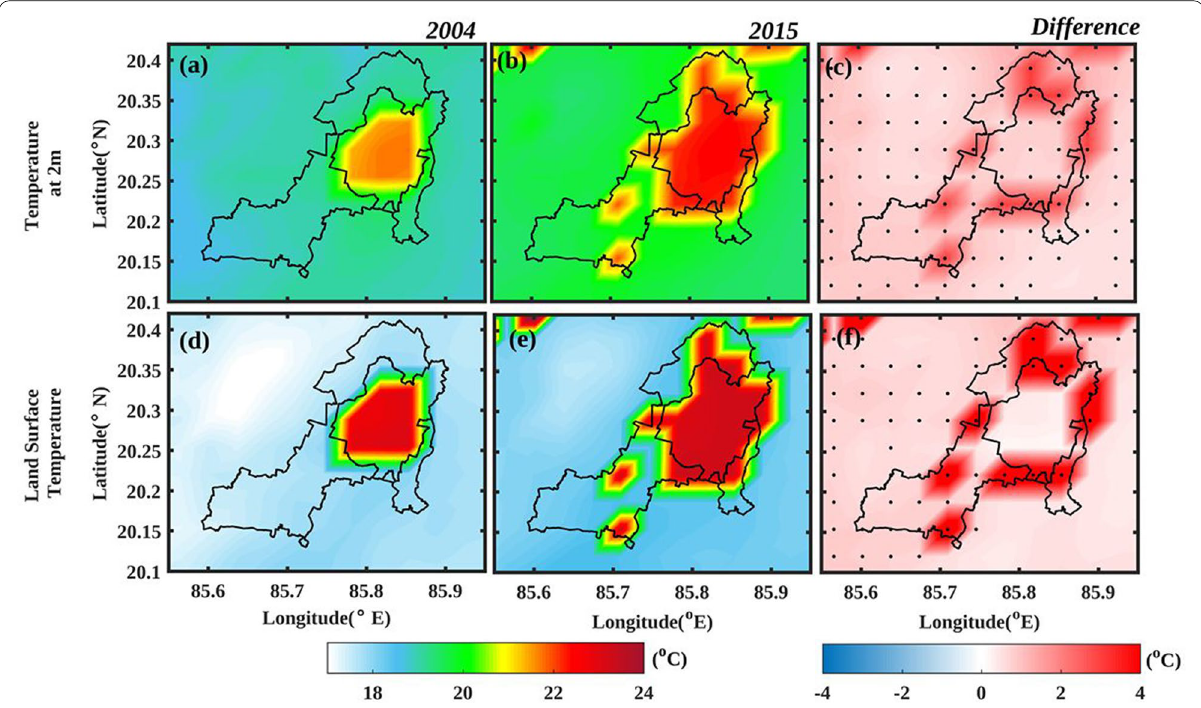
Fig. 4 The model simulated temperature over the city and surroundings. Night time temperature at 2 m for ( a ) 2004 ( b ) 2015 and ( c ) Difference (2015–2004 ( b-a )), Night time land surface temperature for ( d ) 2004 ( e ) 2015 and ( f ) Difference (2015–2004 ( e-d )). The black dots represent statistical significance at a 90% confidence